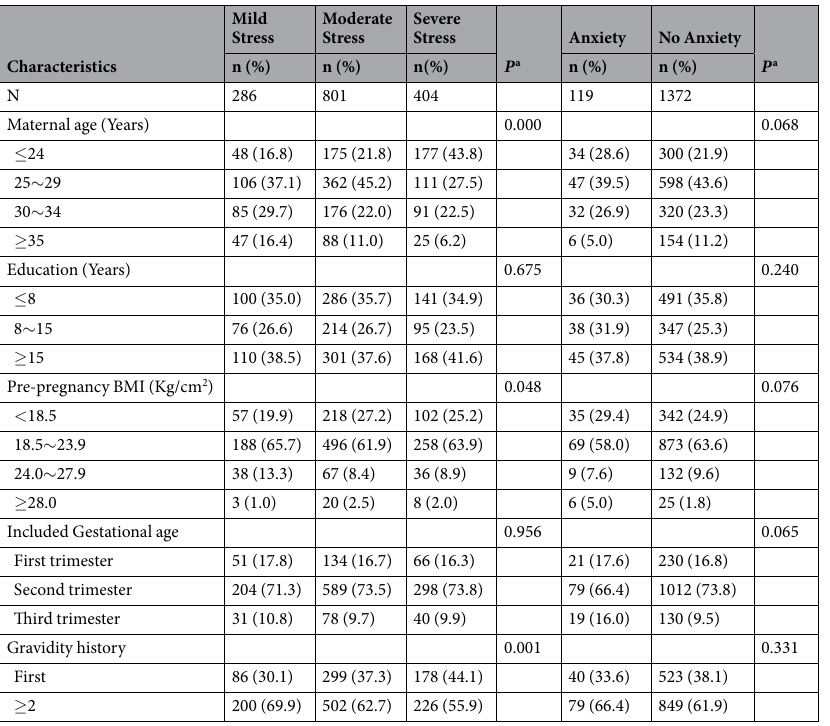
Table 1. Baseline characteristics of pregnant women with prenatal stress and anxiety. BMI, Body Mass Index. a P values were computed with the chi-square